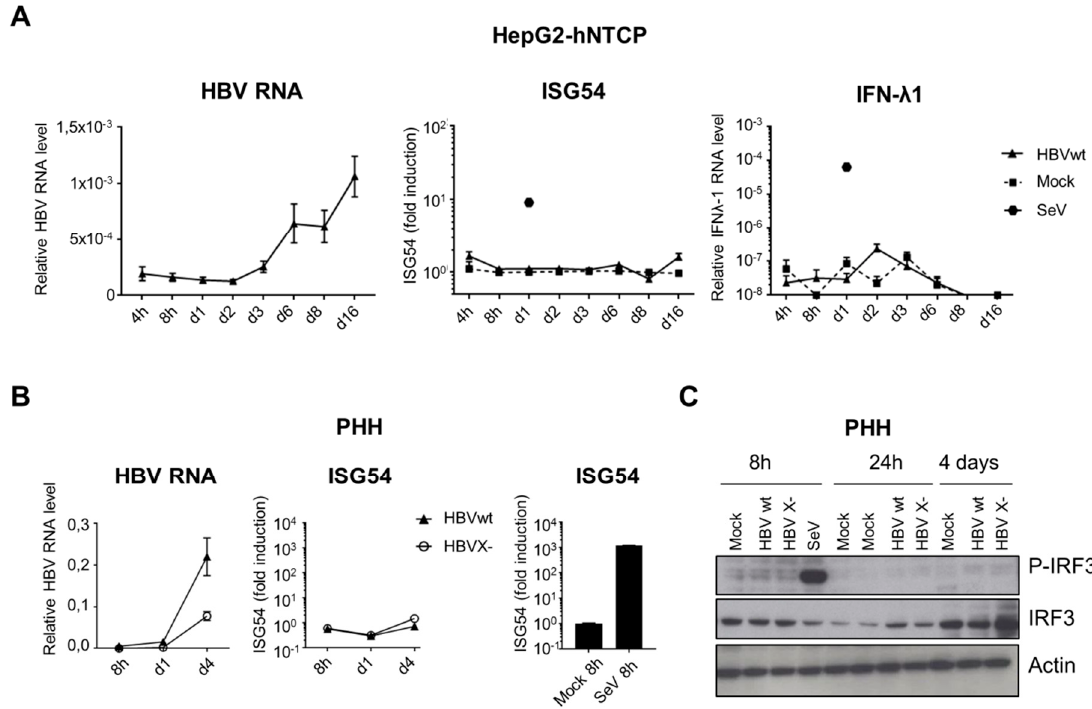
Figure 5. HBVwt or HBV X- infection do not activate nucleic acid-sensing pathways in hepatocytes. HepG2-hNTCP ( A ) or PHH ( B , C ) were infected with HBVwt (MOI 100), HBV X- (MOI 100) or SeV